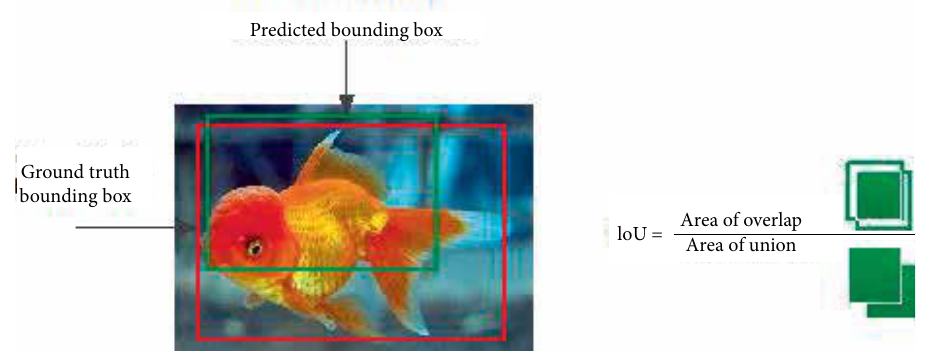
Figure 9: Intersection over union.